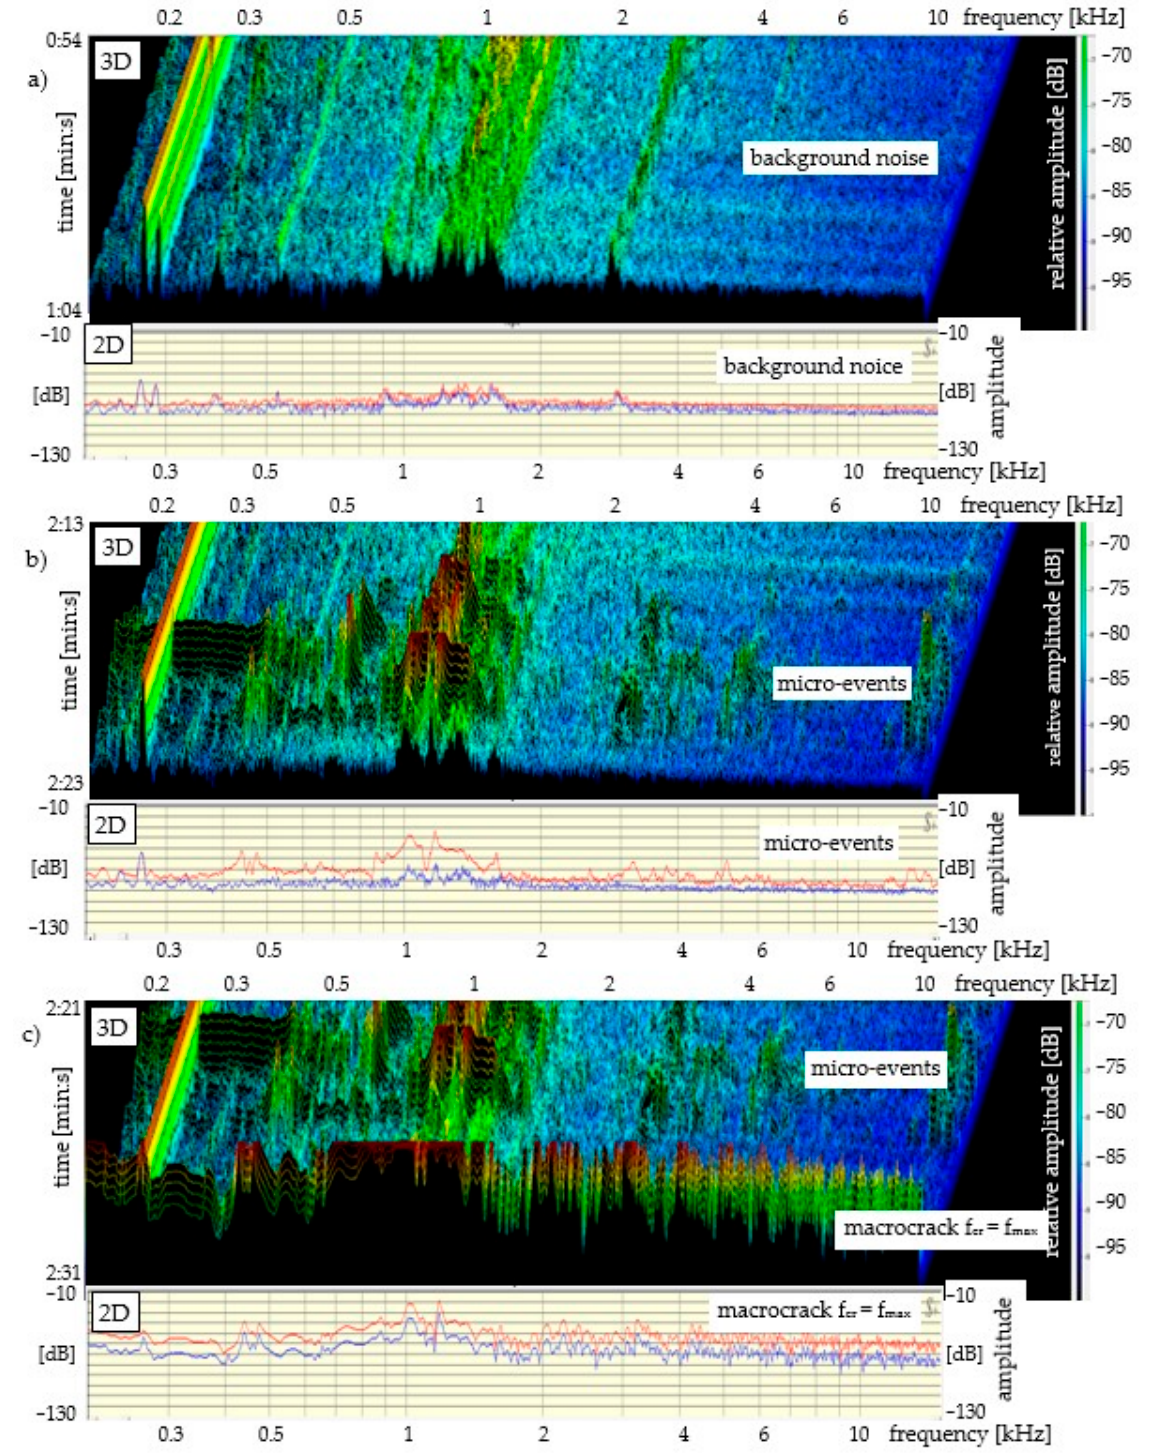
Figure 6. Concrete with traditional continuous reinforcement during the bending test and the AE, with 3D and 2D sound spectra: ( a ) background noise; ( b ) micro-events; ( c ) micro-events and macrocrack f cr = f max .